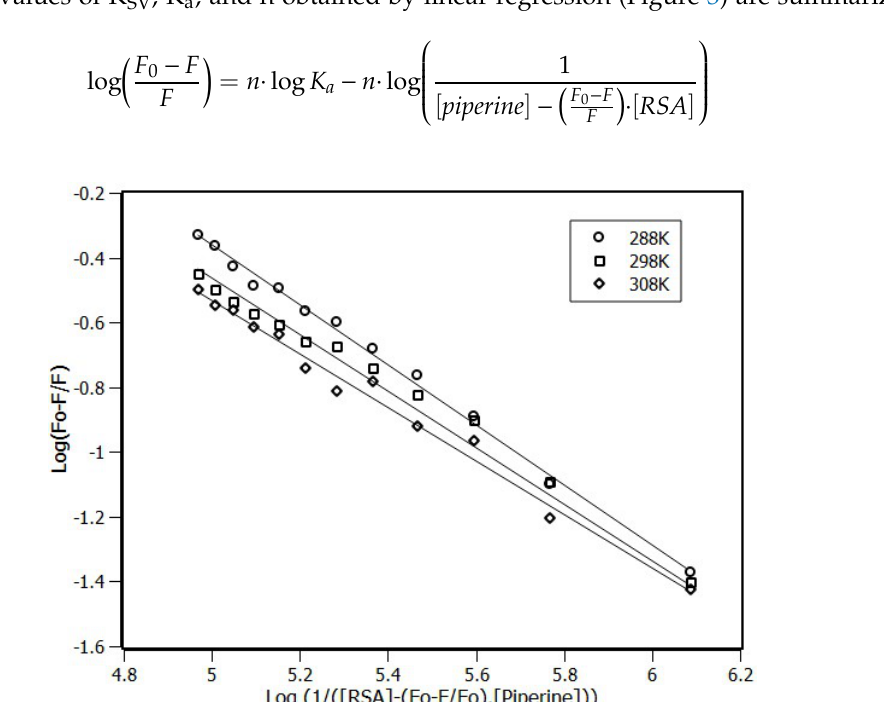
Figure 3. Double-log plots for the fluorescence quenching of RSA (4 µM) by the presence of piperine at 288 K, 298 K, and 308 K. Table 1. Values of the Stern–Volmer constant (K SV ) for tryptophan fluorescence quenching of RSA, binding constants (K a ), and the number of binding sites (n) for the interaction between RSA and piperine at 288 K, 298 K, and 308